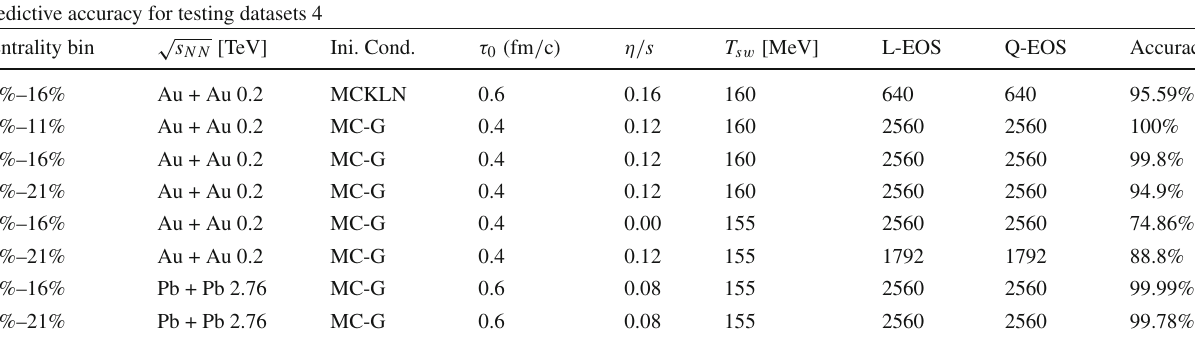
√ s NN ,initialconditions,